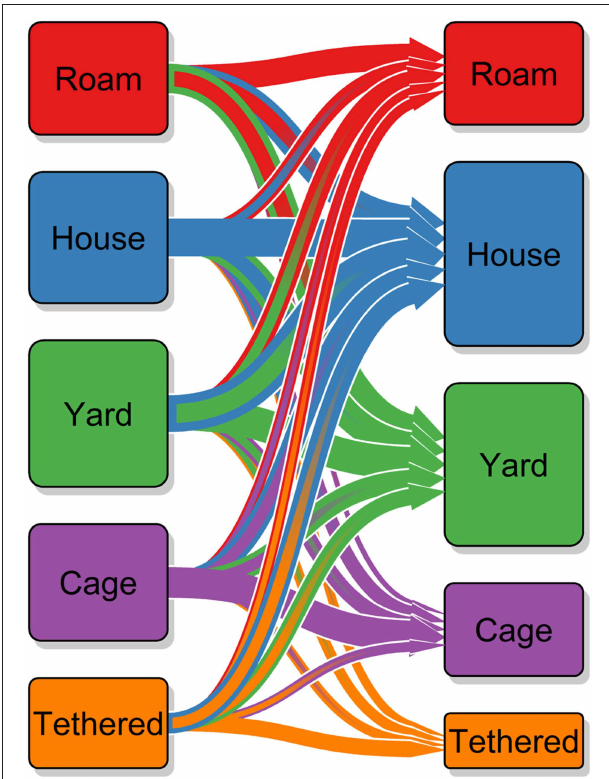
FIGURE 6 | Sankey diagram of transition in dog confinement method used by owners at baseline and at the most recent visit. The arrows show the direction from baseline to most recent visit, the size of the arrows and the size of the cuboid indicate the number of dogs involved; confinement at baseline is shown by the cuboids on the left and confinement at last revisit on the right. The outline color of the arrows also indicates which confinement method the arrow will end up at; the fact that nearly all the largest arrows have a blue outline indicates that a move to being confined to the house is the most common